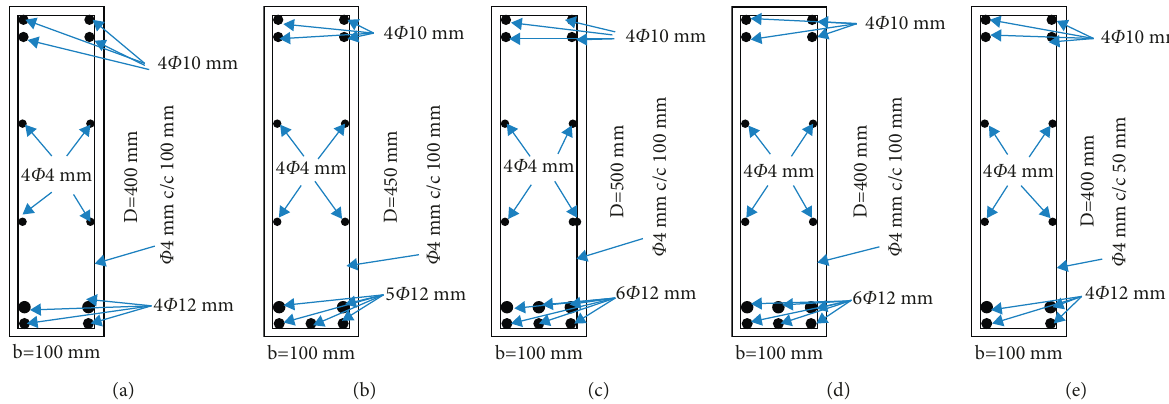
Figure 2: Cross-sectional view of deep beam specimens (a) DB10, DB11, DB12, & DB13, (b) DB20, DB21, DB22, & DB23, (c) DB30, DB31, DB32, & DB33, (d) DB11-L & DB13-L, and (e) DB11-S &